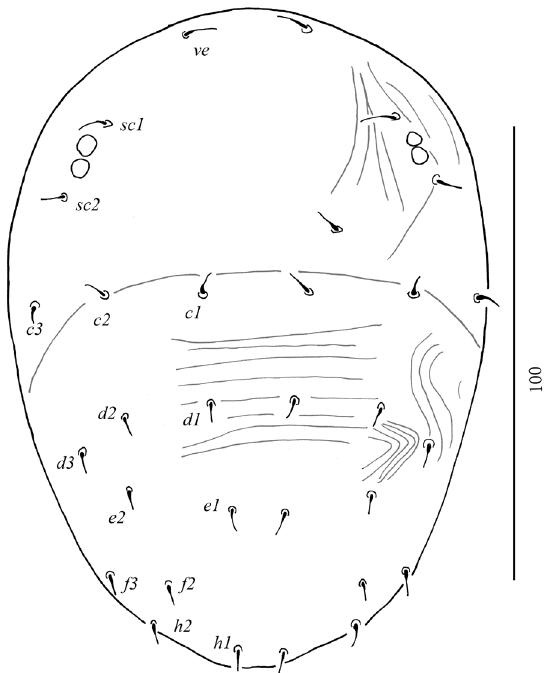
Figure 16. Dorsal view of Aegyptobia bozaii sp. n. paratype, protonymph.